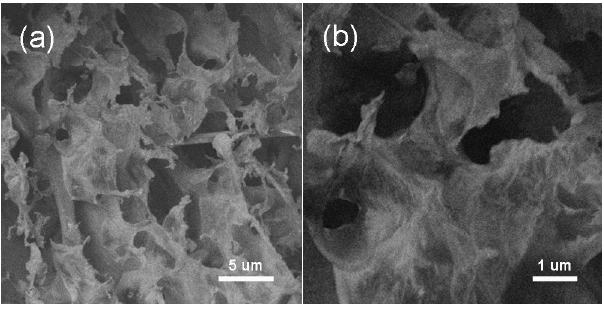
Figure 8. SEM images of the r-GO with different magnifications ( a , b ) .